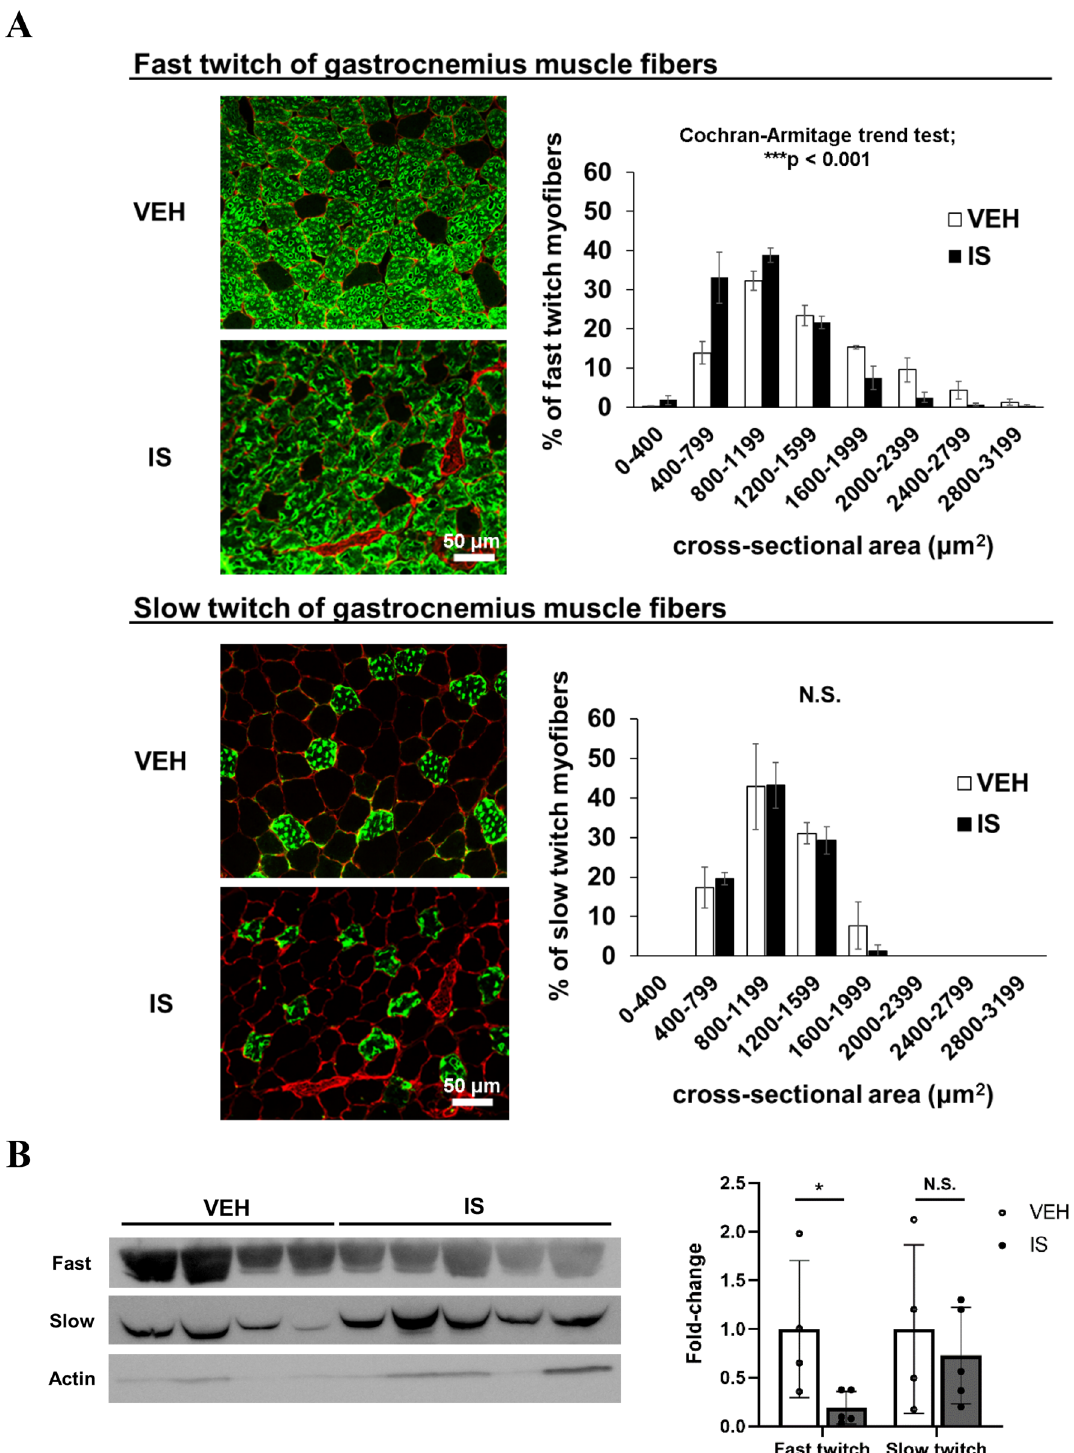
Figure 2. IS administration caused a decrease in predominantly fast-twitch muscle fiber. ( A , B ) Immunohistochemical analysis of ( A ) fast (top, green ) and slow (bottom, green ) myosin heavy chain (MHC) isoforms counterstained with laminin ( red ) was performed for mouse gastrocnemius (GC) muscle cryosections obtained from mice with a unilateral nephrectomy after one-week treatment of vehicle (VEH) or indoxyl sulfate (IS) (left). The scale bar is 50 μm. The cross-sectional area and size distribution of fast and slow myofibers was quantitated (right). As a statistical analysis, a Cochran-Armitage trend test for fiber size distribution was performed. N = 4 mice per group. Error bars denote SEM. ( B ) Western blotting analysis of the fast and slow MHC isoforms was performed in GC muscle (left). Actin was utilized as a loading control. Quantitative densitometric data from western blots are shown (right). N = 4–5 mice per group. A full-length view of the membrane is shown in the supplementary Fig. 2. Error bars denote SEM. * p < 0.05, N.S.; no